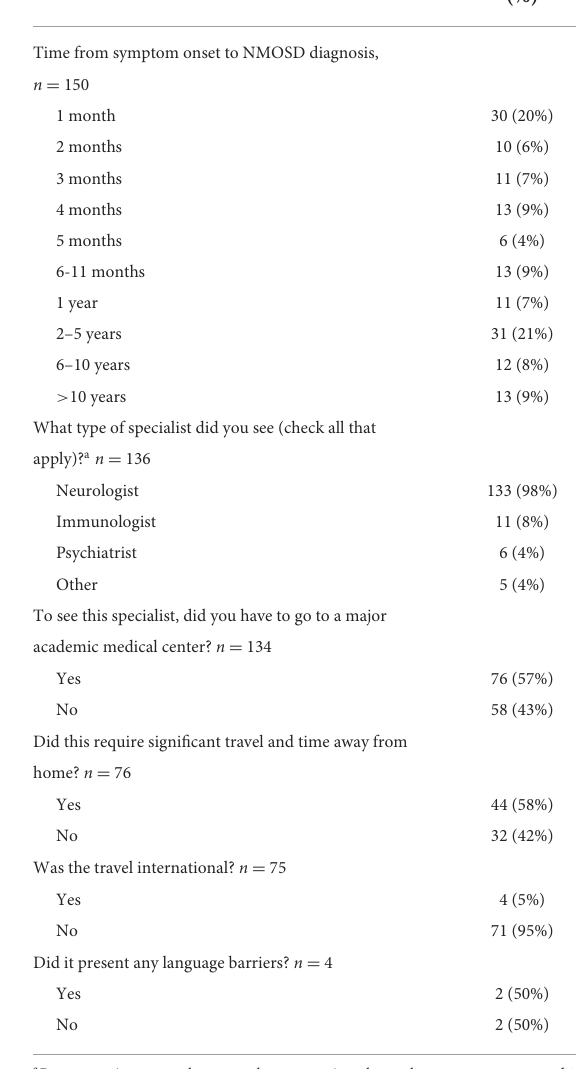
TABLE 3 Patient transition from a general practioner to a specialist.